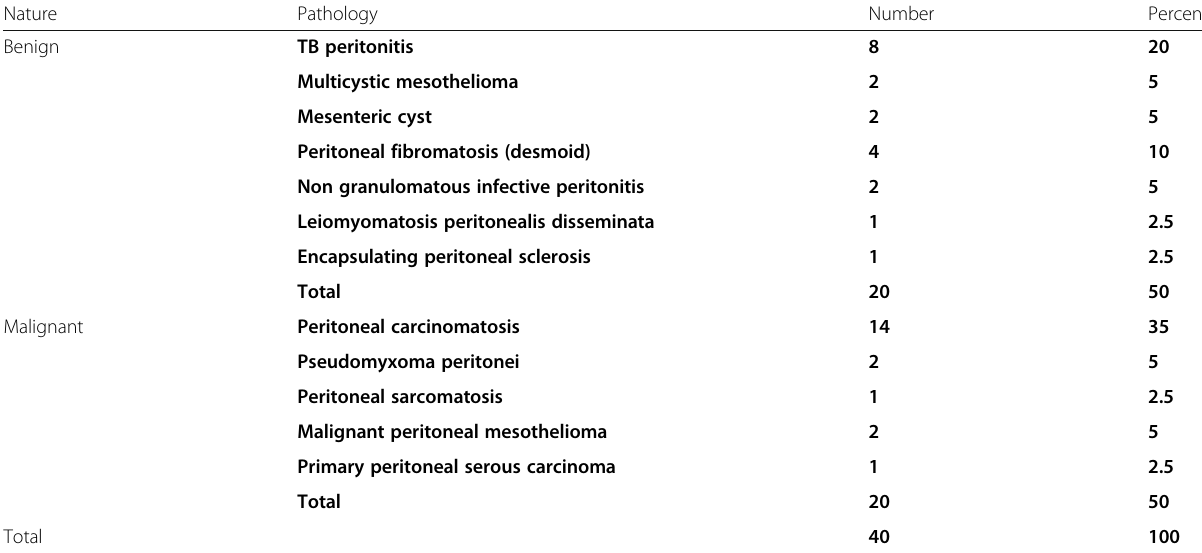
Table 1 Pathological diagnosis of the peritoneal lesions included in the study Nature Pathology Number Percent Benign TB peritonitis 8 20 Multicystic mesothelioma 2 5 Mesenteric cyst Peritoneal fibromatosis (desmoid) 10 Non granulomatous infective peritonitis 5 Leiomyomatosis peritonealis disseminata 2.5 Encapsulating peritoneal sclerosis Total Malignant Peritoneal carcinomatosis 35 Pseudomyxoma peritonei Peritoneal sarcomatosis Malignant peritoneal mesothelioma Primary peritoneal serous carcinoma